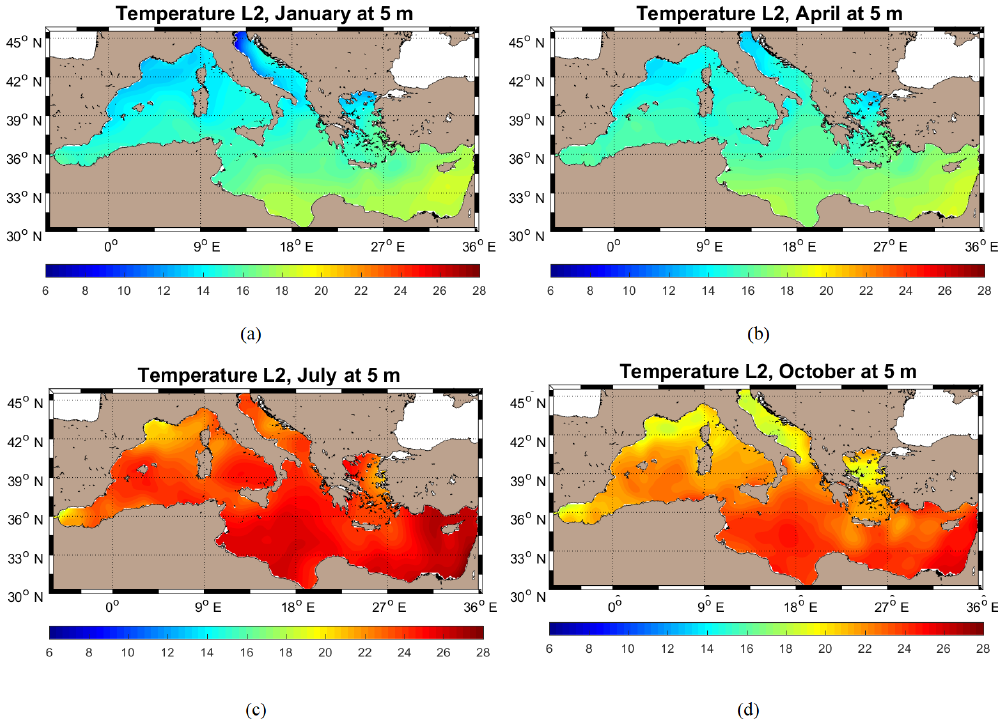
Figure 5. Surface temperature climatology at 5m in (a) January, (b) April, (c) July and (d)